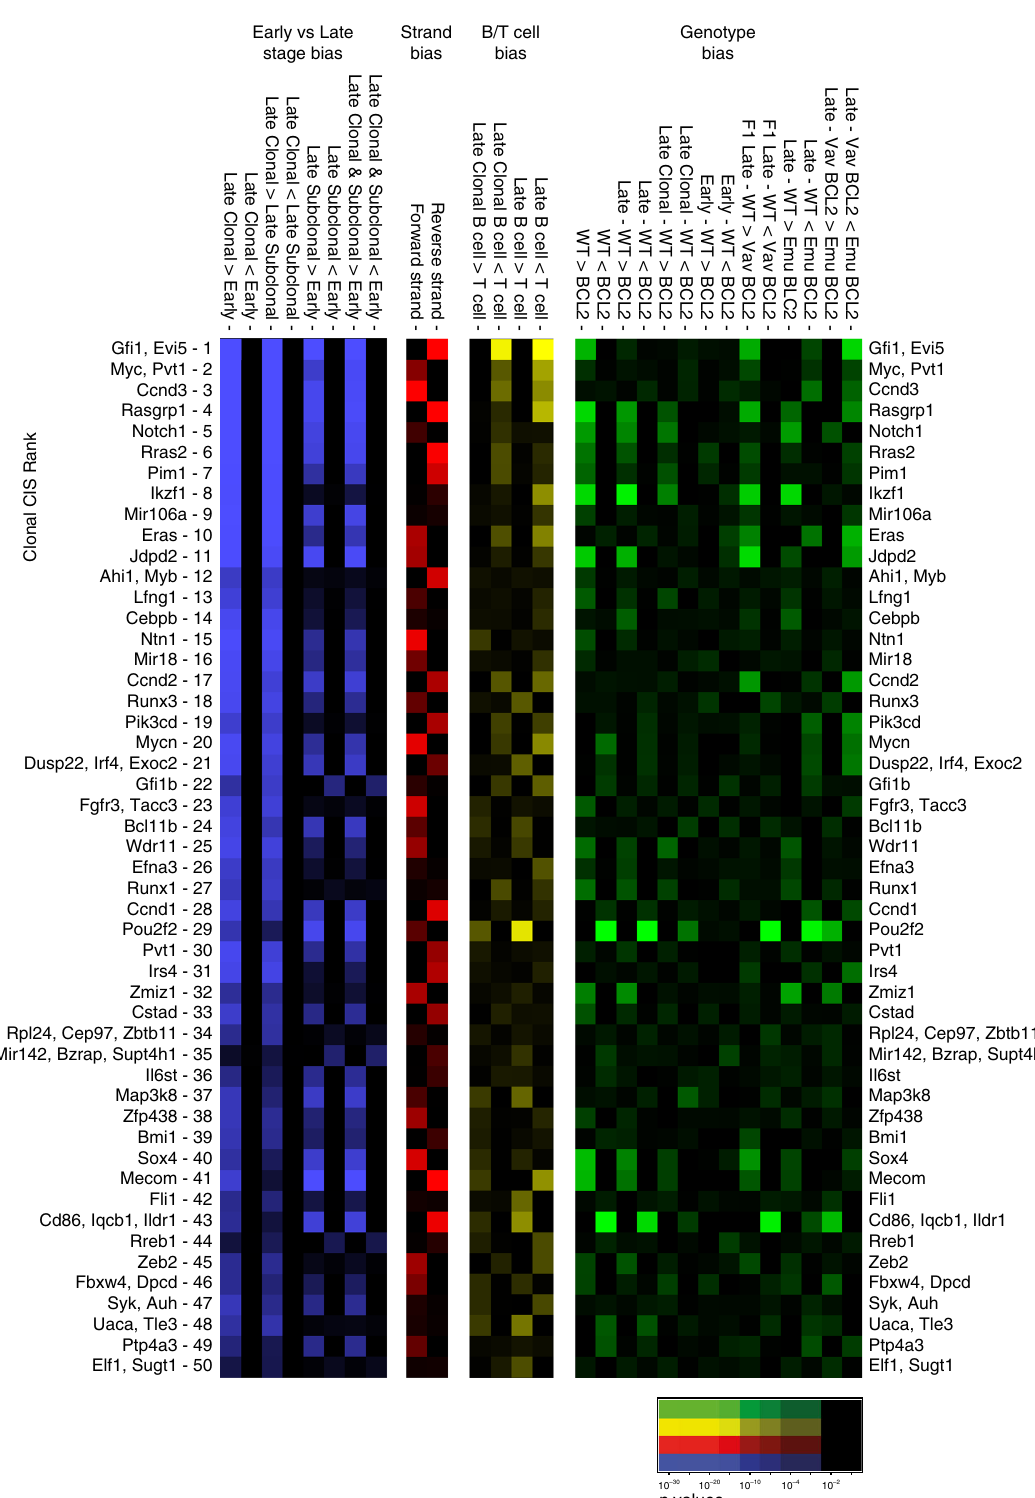
Fig. 4 Multiple criteria indicate selection of both clonal and subclonal mutations at CIS loci. Four heat maps representing the relative levels of selection observed between different categories of integrations. Fisher ’ s exact tests were performed counting the inserts within 100kb windows surrounding each of the top 50 clonal insert loci. Blue indicates comparisons between early and late-stage integrations. Red represents integration orientation bias (forward or reverse strand). Yellow represents speci fi city for B cell (>50% CD19) versus T cell lymphomas. Green represents speci fi city between different genotypes. p -Values for Fisher ’ s exact tests are indicated by color